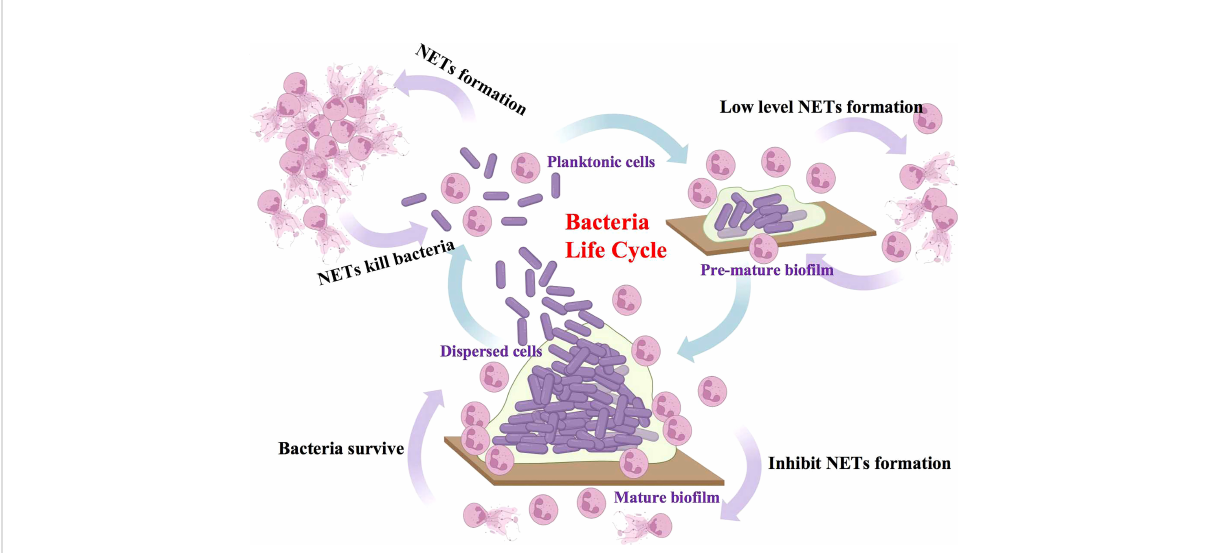
FIGURE 7 Proposed model of discriminatively NETs reaction of neutrophils to different physiological states of S. mutans . In the lifespan of S. mutans , the free- fl oating planktonic bacteria exhibited an active NETs response, which assisted in the elimination of bacteria in turn. However, as bacteria assembled into the mature bio fi lm community, they exhibited a reverse negative NETs response and as a result, protected bacteria from the immune